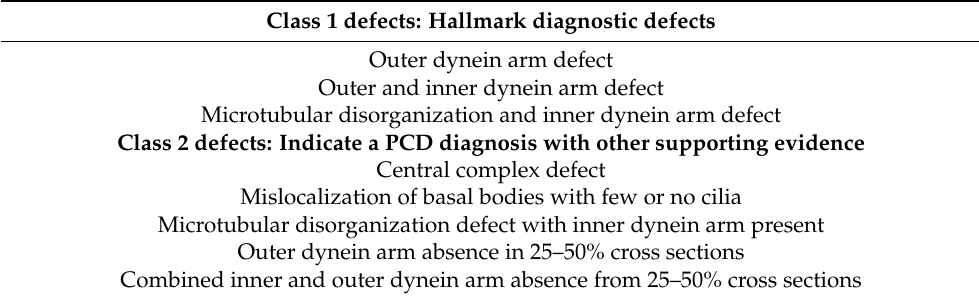
Table 1. International guidelines table classifying defects into class 1 and class 2 defects [20]. Class 1 defects: Hallmark diagnostic defects Outer and inner dynein arm defect Microtubular disorganization and inner dynein arm